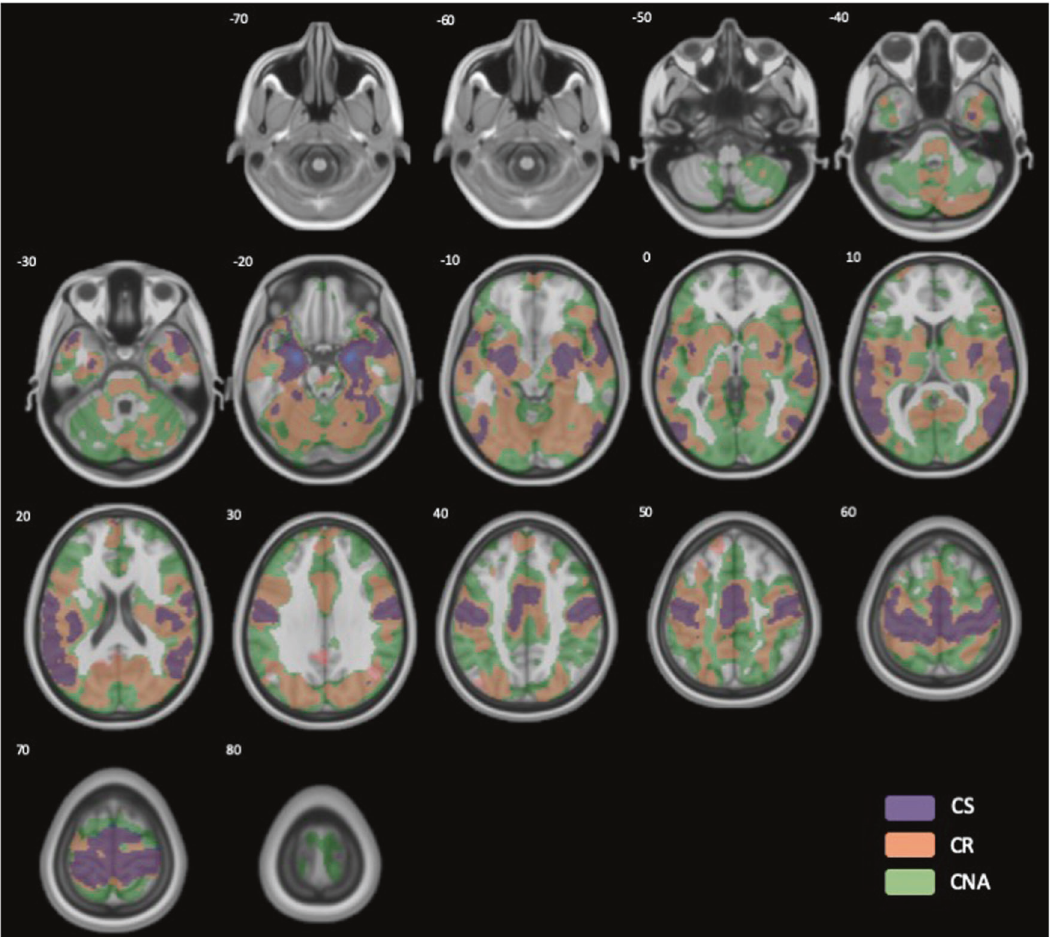
CR Compulsive Reactive (orange), CS Compulsive Stressed subtype